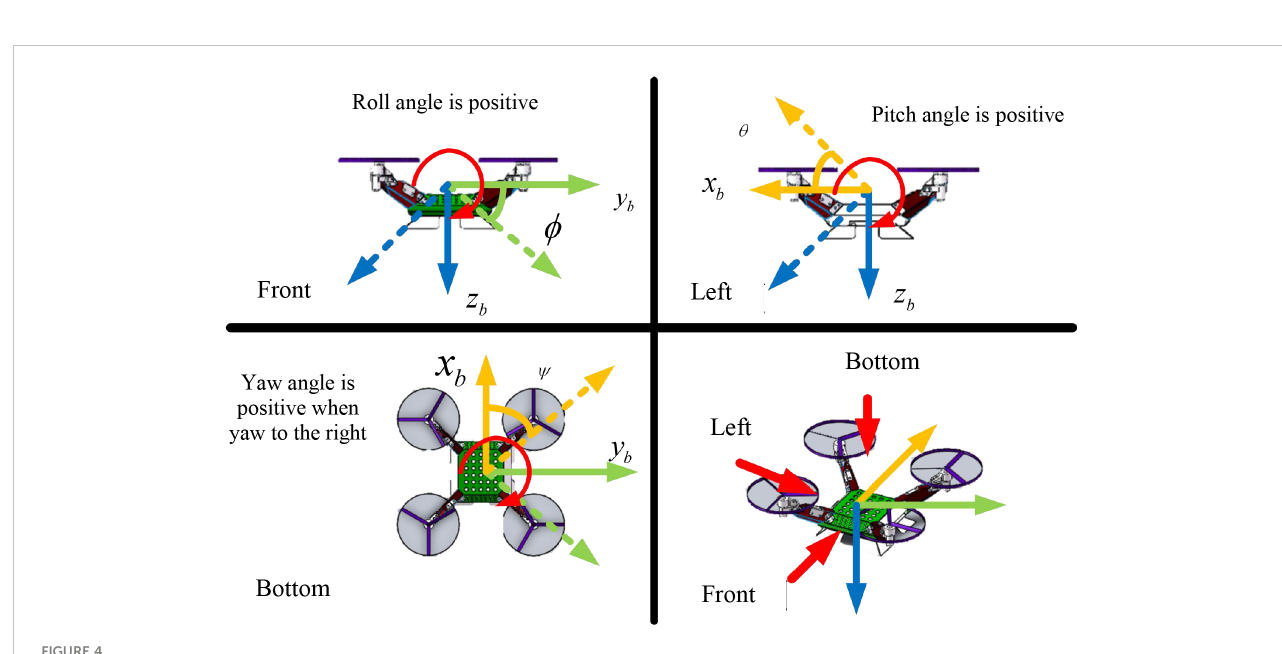
FIGURE 4 Attitude angle of agricultural